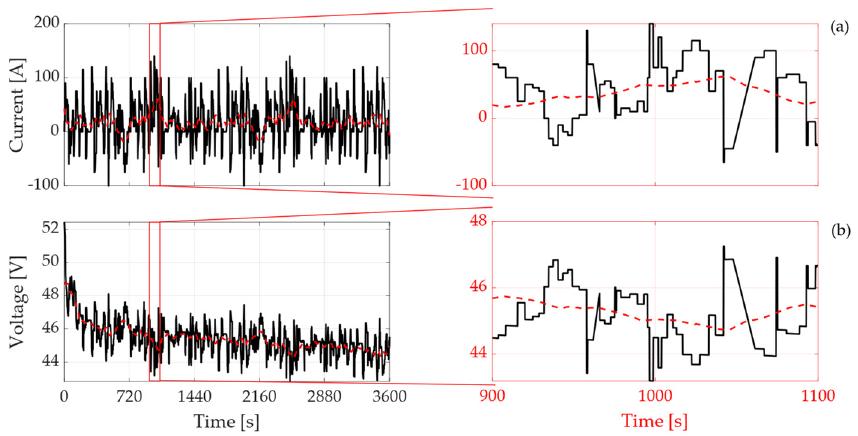
Figure 9. Testing dataset A: ( a ) current (solid black) and averaged current (dashed red), ( b ) voltage (solid black) and averaged voltage (dashed red).